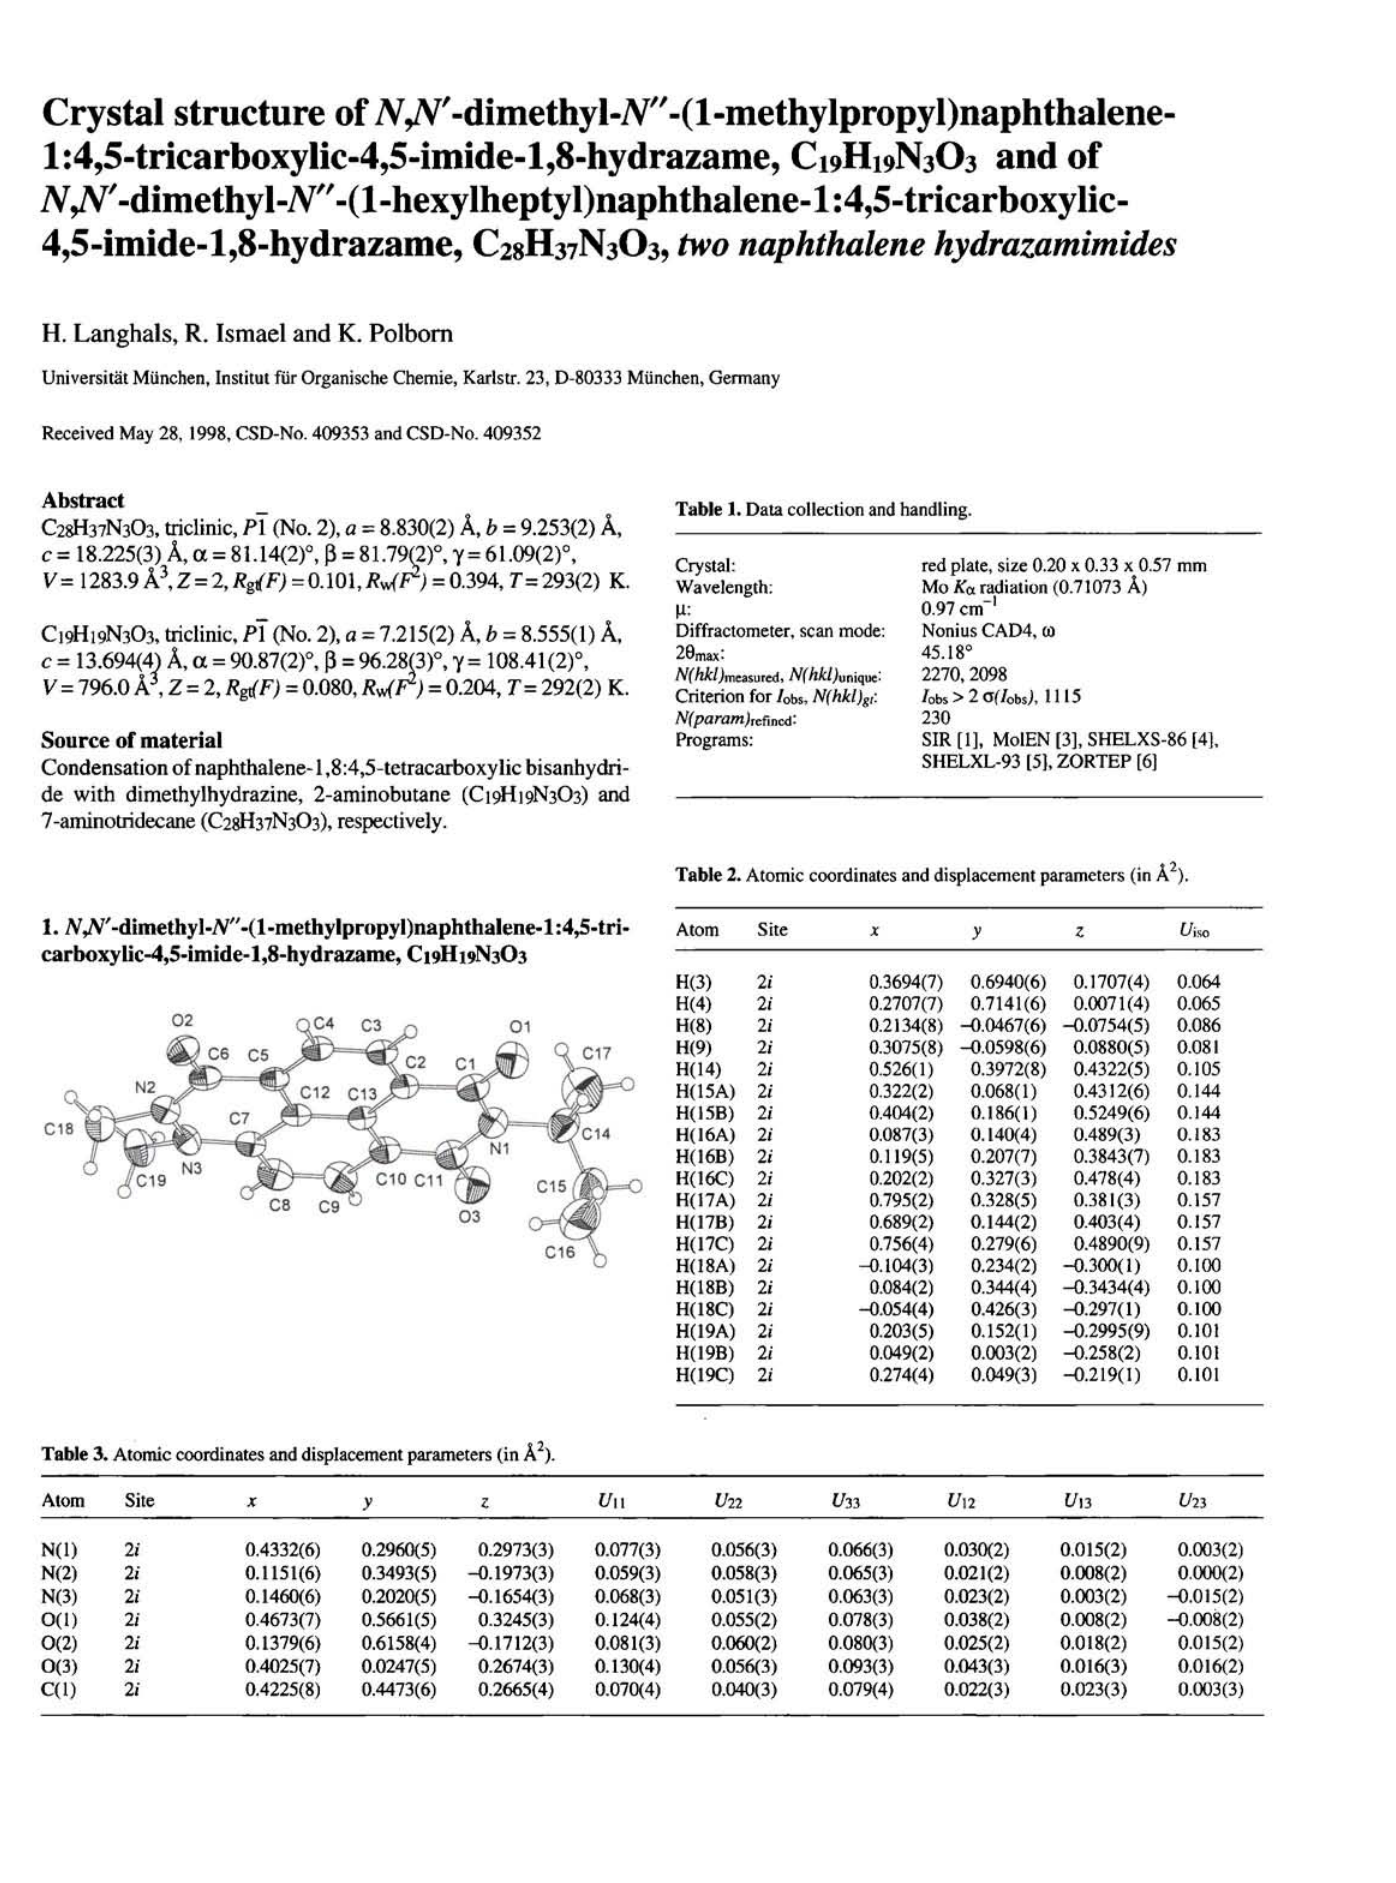
Table 3. Atomic coordinates and displacement parameters (in Â 2